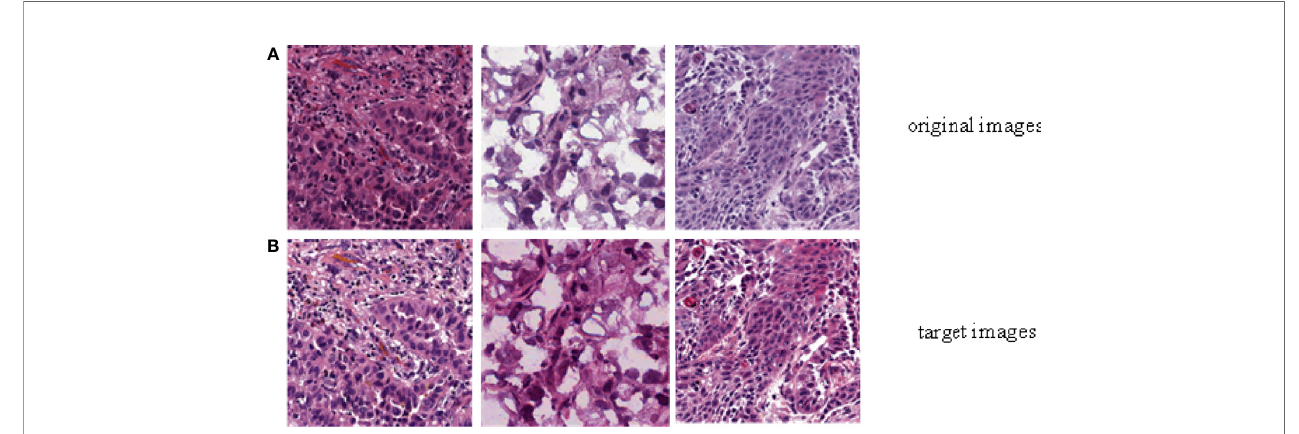
FIGURE 3 | Color normalization model of H&E stained image. The image was normalized by the depth convolution Gaussian mixture model (DCGMM), (A) Original images, (B) Color normalized